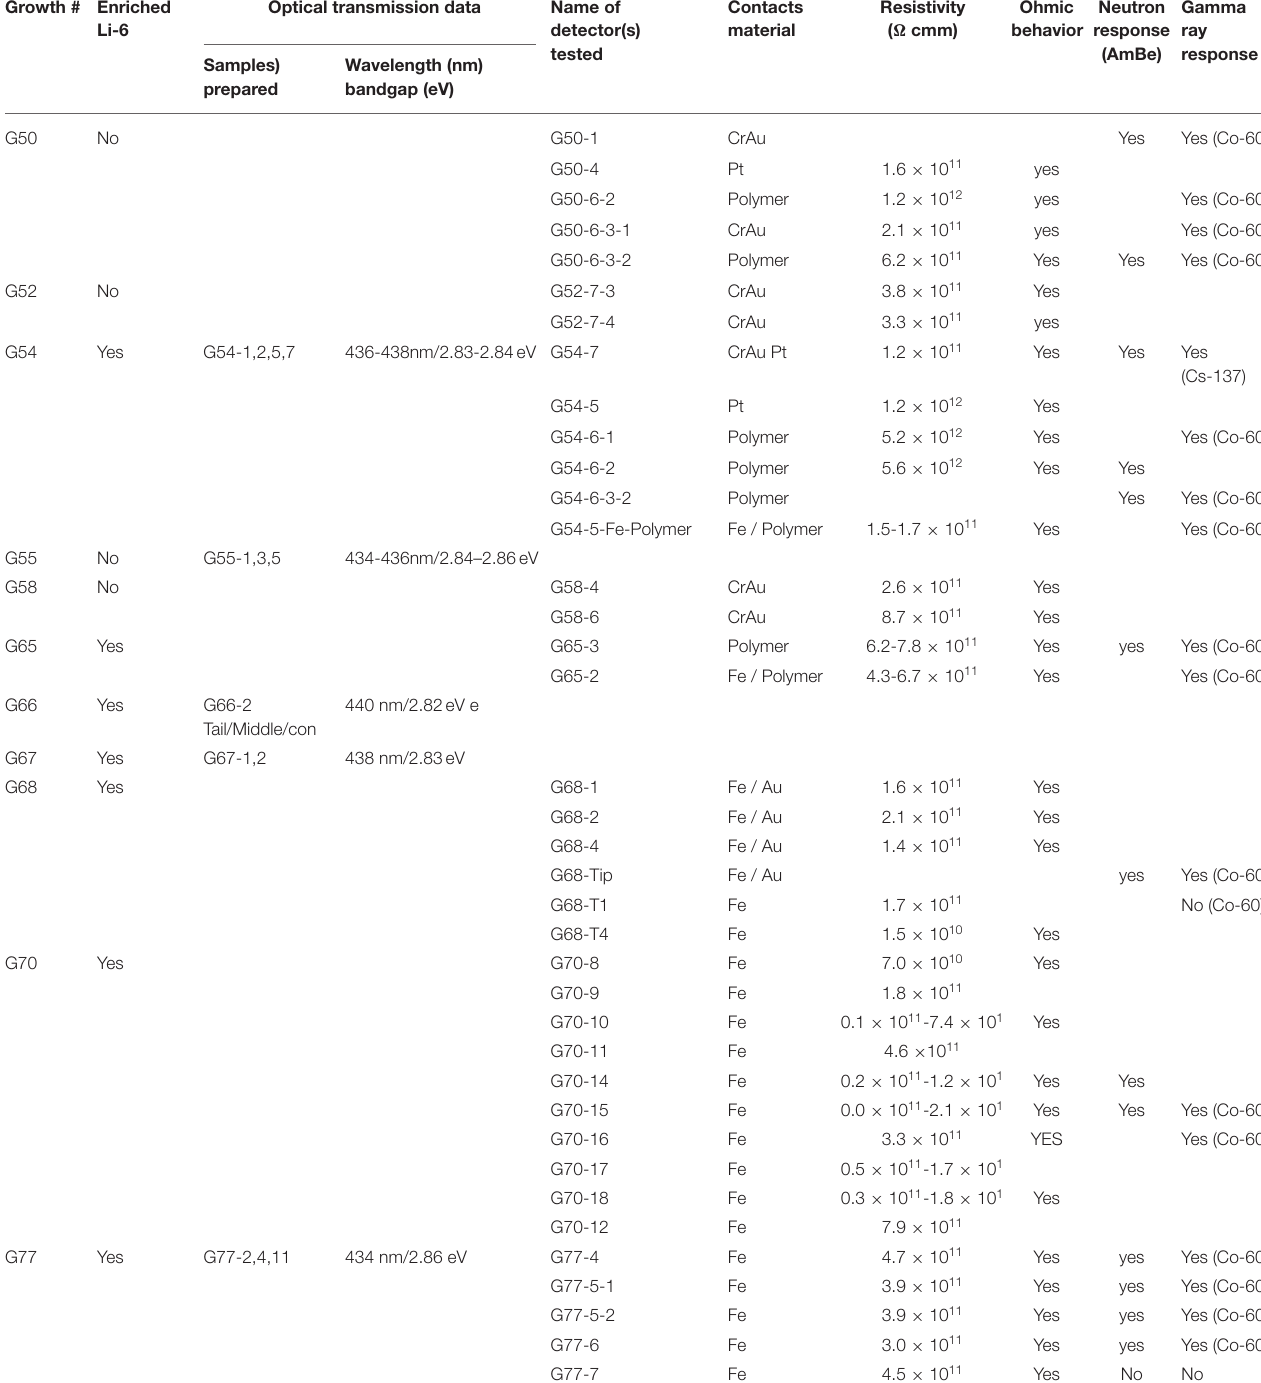
TABLE 2 | Characteristics of LiInSe 2 crystals and